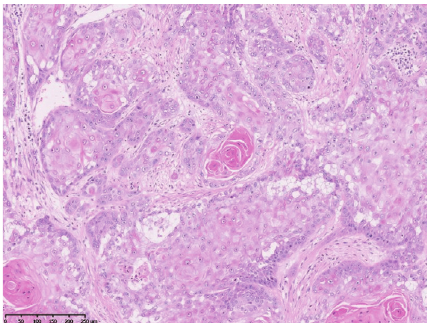
Figure 3: Microphotograph showing a well-differentiated squa- mous cell carcinoma (hematoxylin-eosin; ×